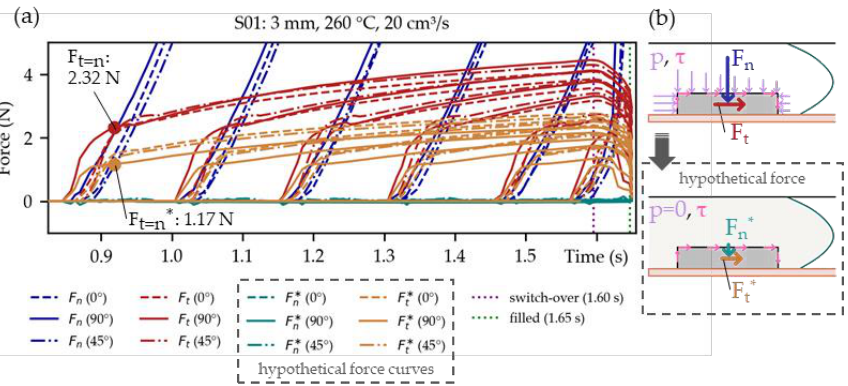
Figure 13. Comparison of the simulated normal (F n ) and tangential (F t ) forces with the hypothetical force curves in the normal (F n *) and tangential (F t *) direction ( a ). For the latter, the filling pressures were virtually set to zero ( p = 0 ) as illustrated in ( b ). Therefore, the calculated tangential forces (F t *) were lower compared to the tangential forces (F t ) obtained previously ( F t = n* ≅ 50%∙F t = n ), indicating the substantial contribution of the pressure gradient during filling.